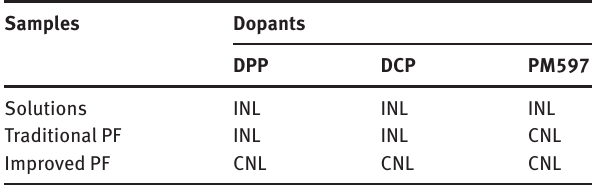
Table 1: Types of random laser in different random systems. a Samples